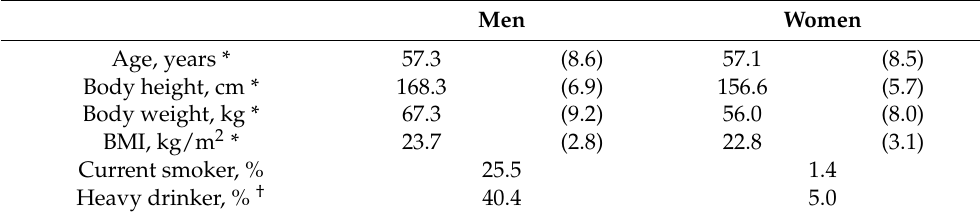
Table 1. Characteristics of the subjects (94 men and 141